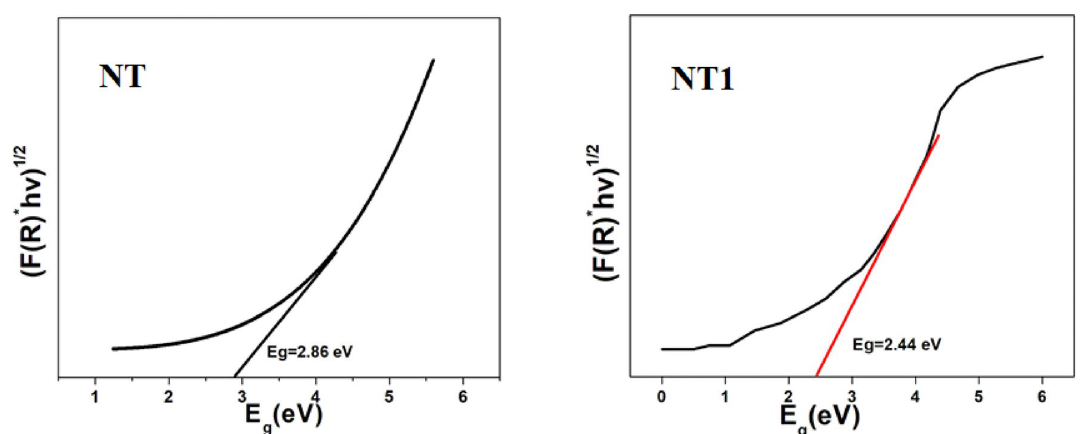
Figure 6. Tauc plot of NT and